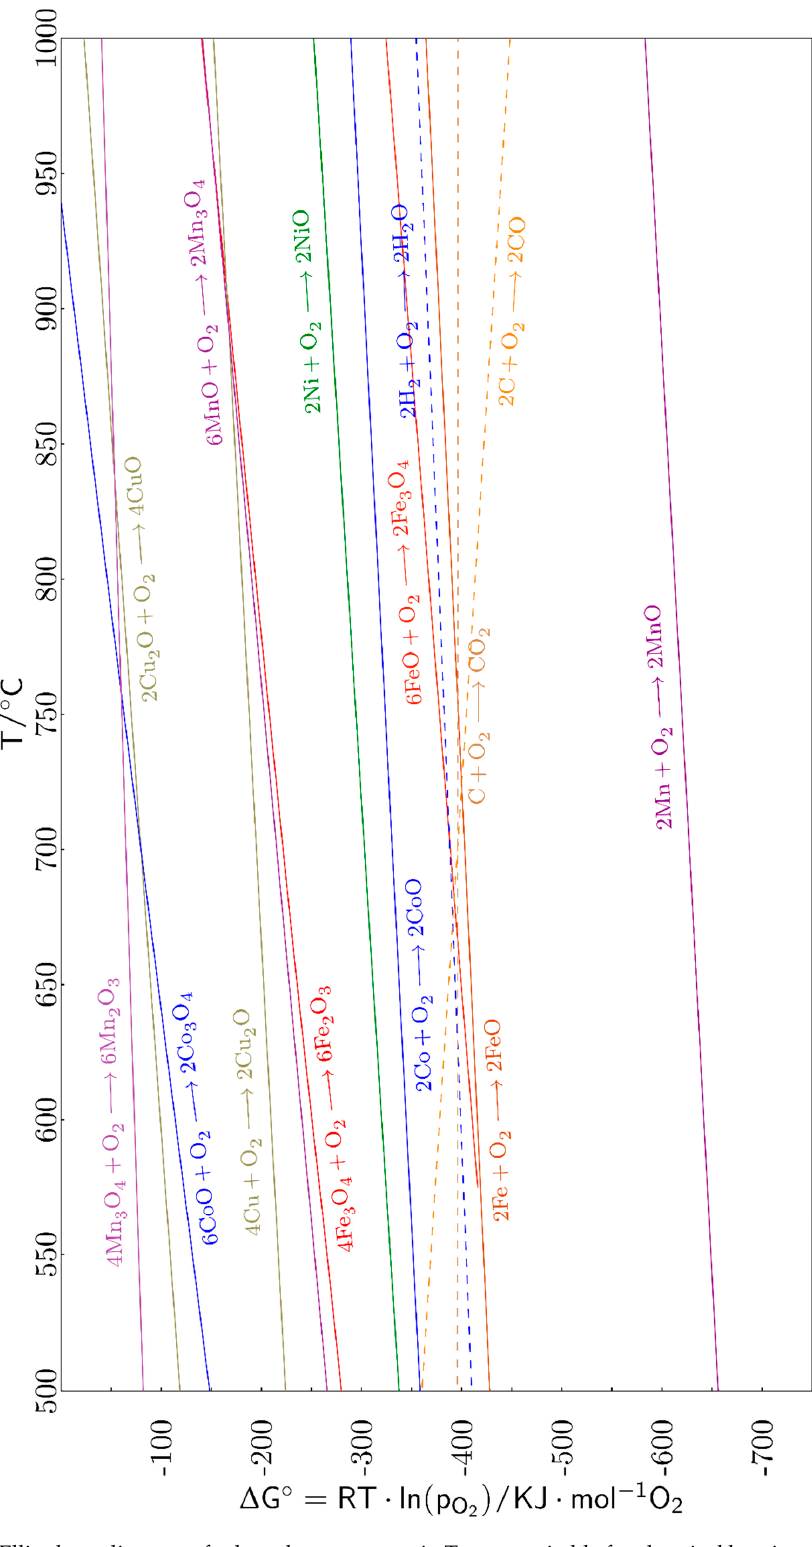
Figure 9. Ellingham diagram of selected components in T-range suitable for chemical looping processes, calculated by FACTSAGE (1 atm)